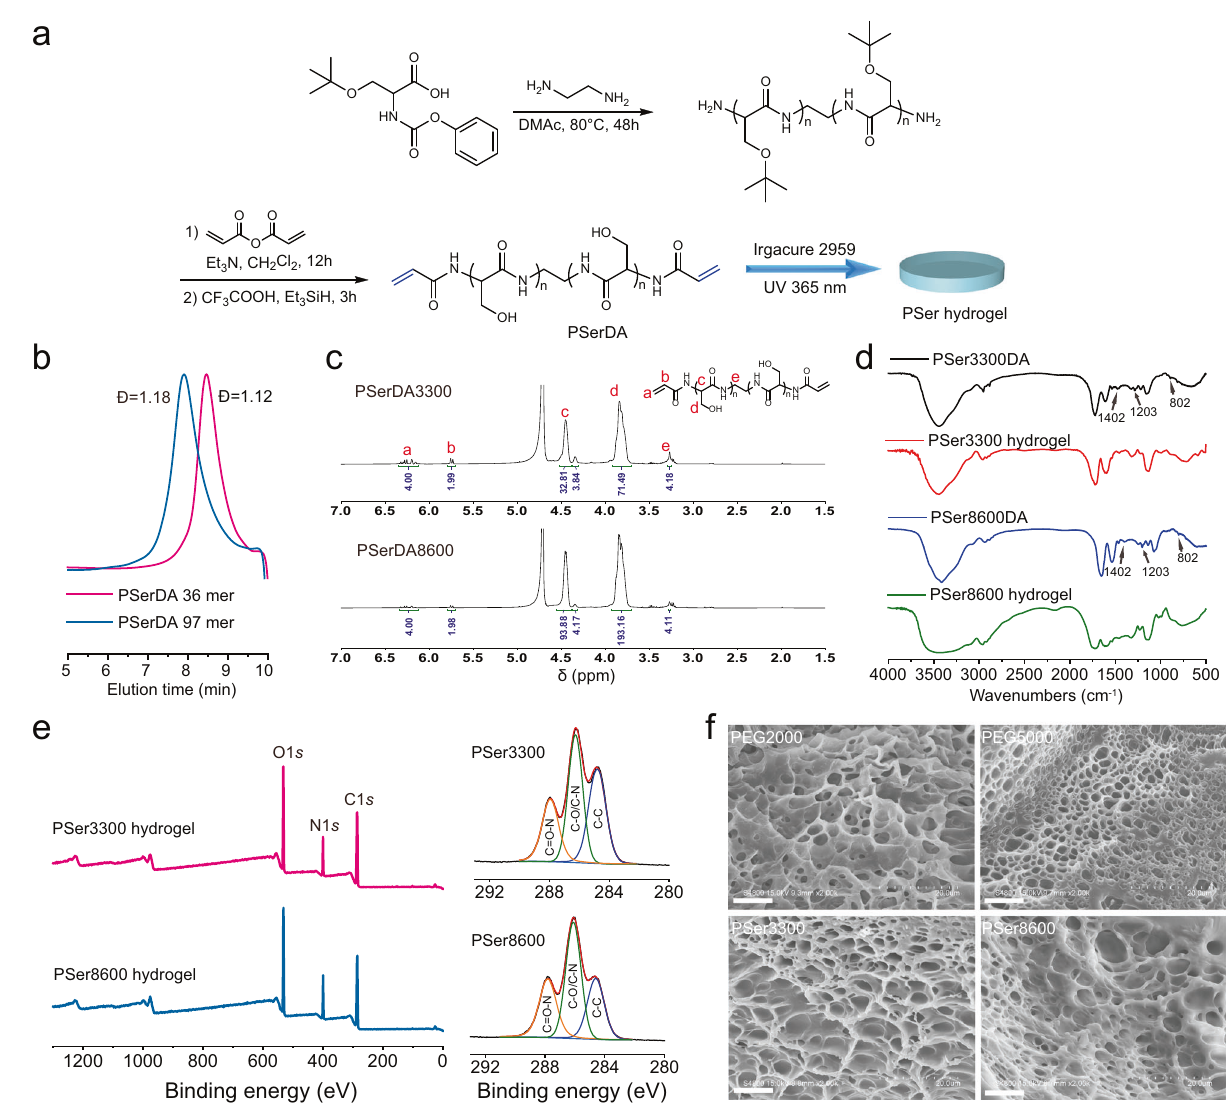
Fig. 2 Preparation and characterization of PSer hydrogels. a Synthesis of PSer hydrogel precursor PSerDA and preparation of PSer hydrogels. b GPC traces of two PSerDA at a different length, using THF as the mobile phase at a fl ow rate of 1 mL/min. c 1 H NMR spectra (400 MHz, D 2 O) of PSerDA. d FTIR spectra of PSerDA and PSer hydrogels. e XPS spectra of PSer hydrogels. f SEM images of hydrogels, scale bar: 20 μ